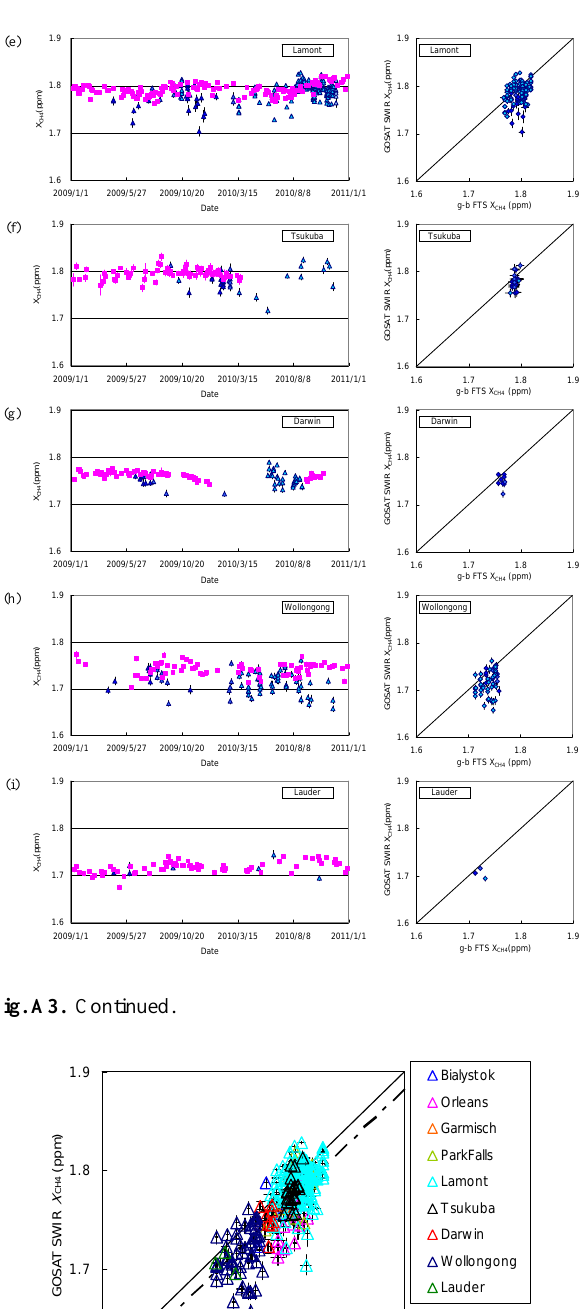
The difference of the GOSAT data to the g-b FTS data is − 8.25 ± 3.97 ppm or − 2.1 ± 1.0 %. The time series of the GOSAT and g-b FTS data for X CH are shown on the left and their scatter diagrams on the right at in Fig. B3. Figure B4 shows the scatter diagram between the 4 GOSAT data and the g-b FTS data for all sites. The slope of the regression line with no intercept is 0.992 and the correla- tion coefficient is 0.712. The difference between the GOSAT data and the g-b FTS data at each site is shown in Table B2. The difference of the GOSAT data to the g-b FTS data is − 14.8 ± 22.6 ppb or − 0.83 ± 1.3